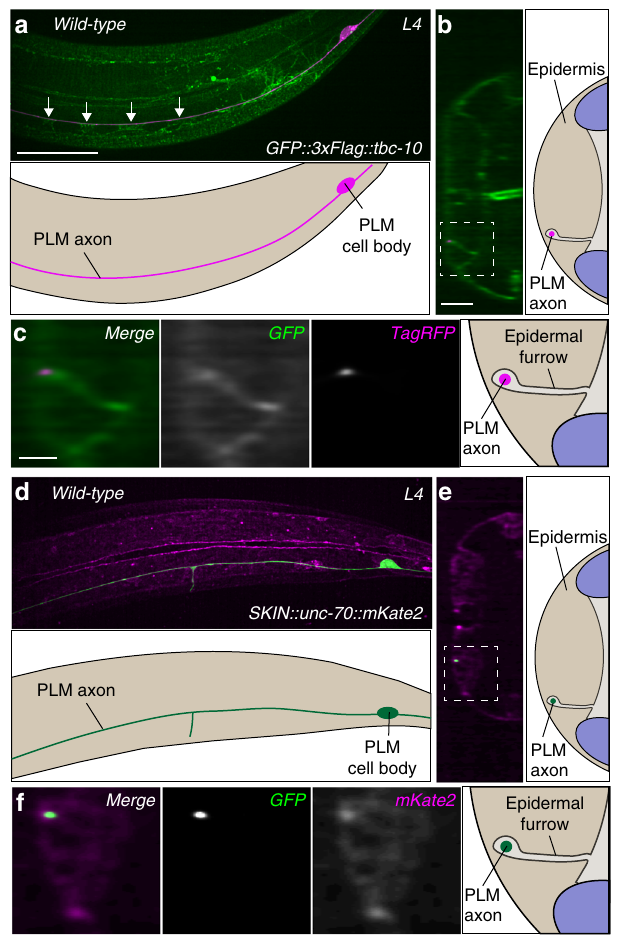
Fig. 2 TBC-10 and UNC-70/ β -spectrin localize to the epidermal membrane. a Deconvolved spinning disk confocal maximum projection and scheme of GFP::3xFlag::TBC-10 localization in a typical wild-type animal with the PLM neuron labeled with a cytosolic TagRFP ( Pmec-17::tagRFP ; magenta). Arrows indicate regions of the epidermal furrow visible in a lateral perspective. b An orthogonal perspective and scheme